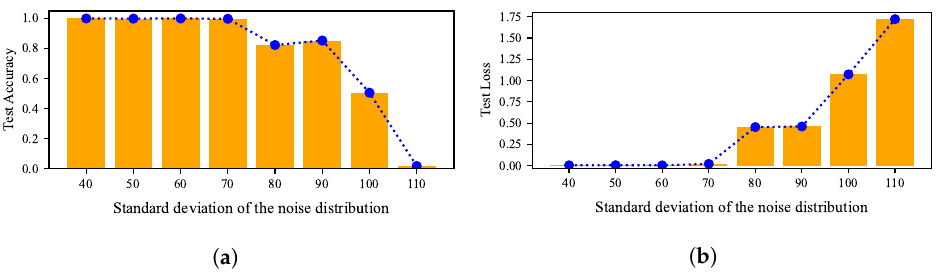
Figure 13. The effect of corrupting the green hen AVM data bundle by Gaussian noises of different levels on the test accuracy ( a ) and loss ( b ). The recognition model uses the LeNet5 architecture.